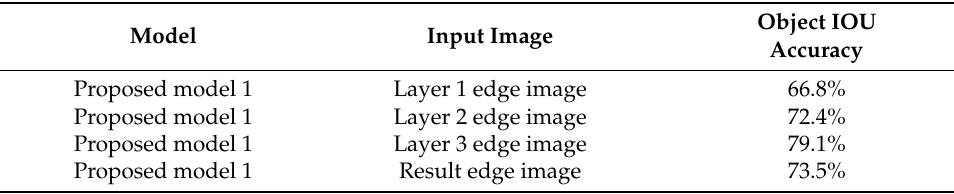
Table 5. The object IOU accuracy of the proposed model 1 for each edge image.